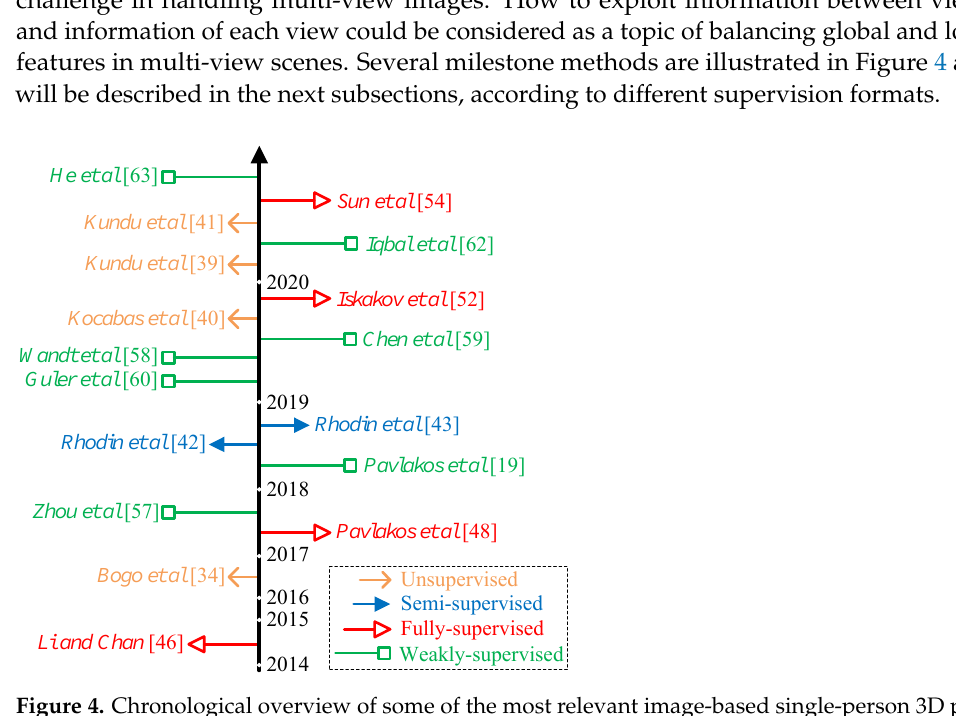
Figure 4. Chronological overview of some of the most relevant image-based single-person 3D pose estimation